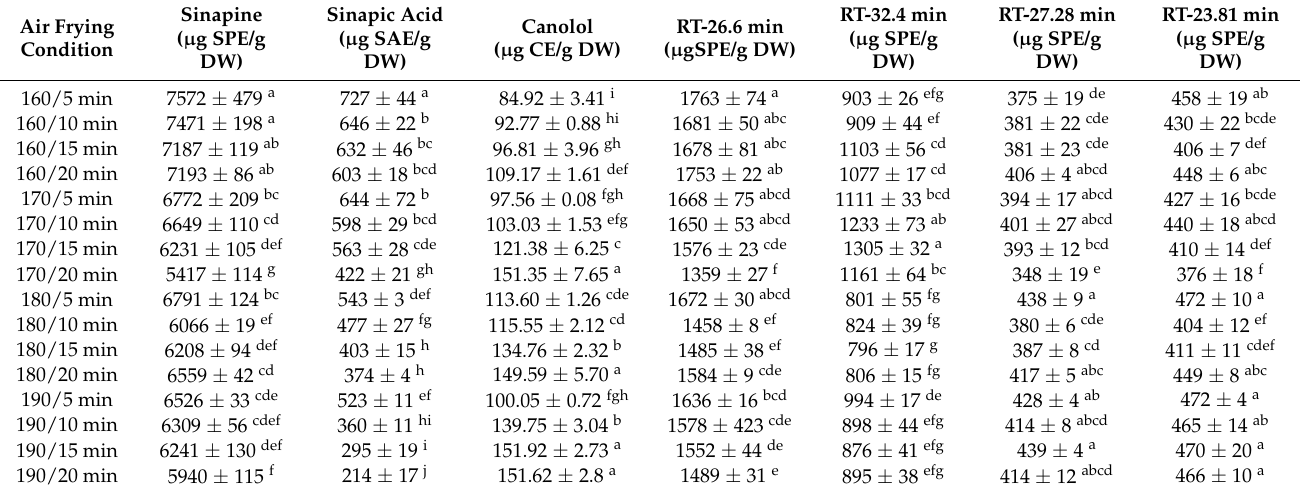
Table 1. Effect of air frying pre-treatment on the recovery of major sinapic acid derivates (SADs) in de-oiled canola meal. Canola meal-derived sinapic acid derivatives